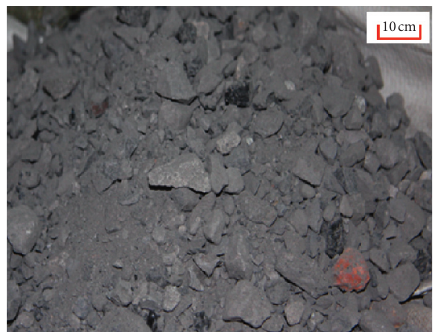
Figure 2: Coal gangue after the second